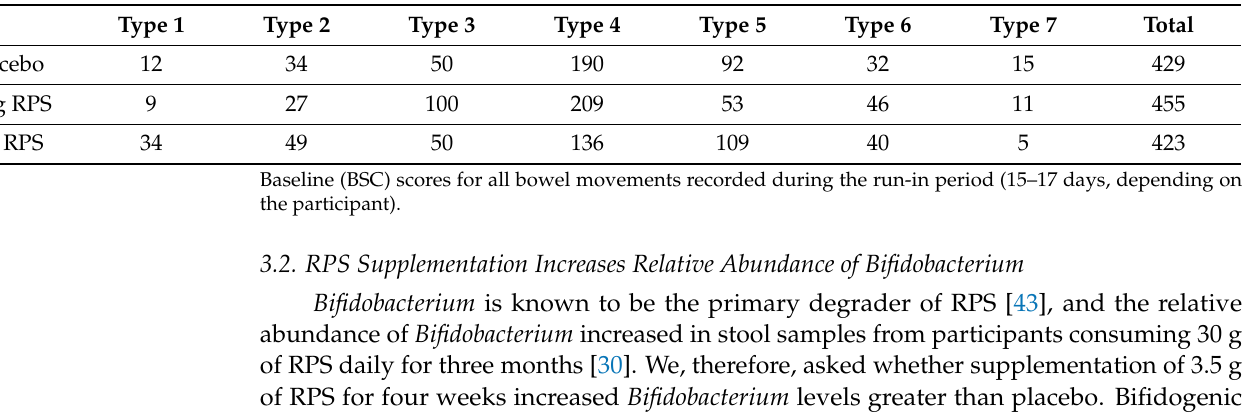
Table 3. Baseline Bristol Stool Chart (BSC)